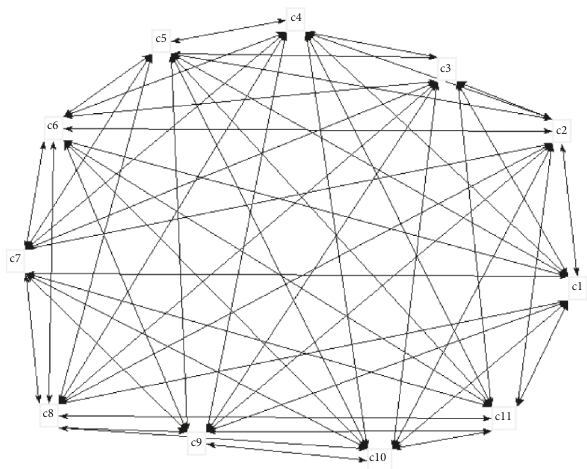
Figure 5: Final classified